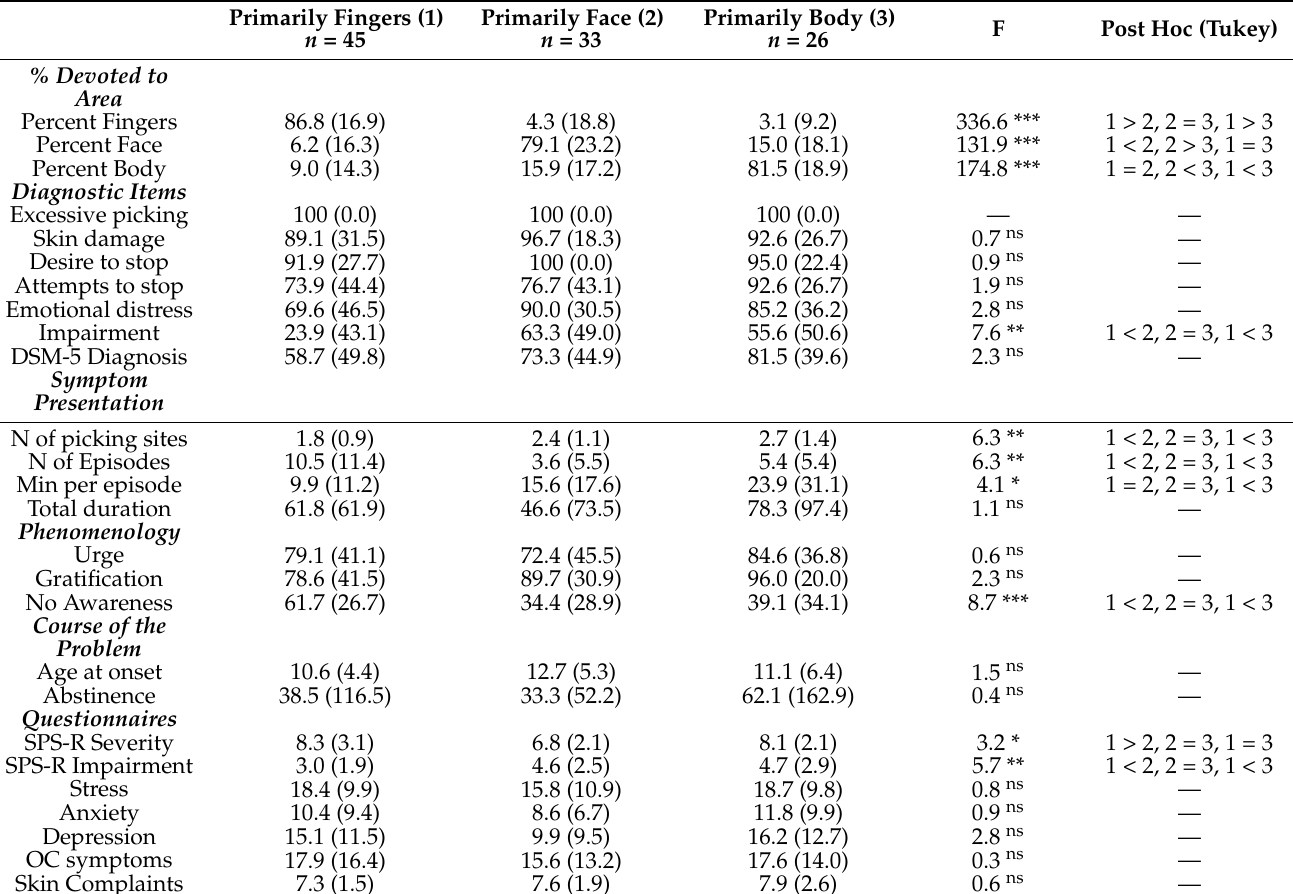
Table 5. Comparison of clinical features across different primary picking sites 1